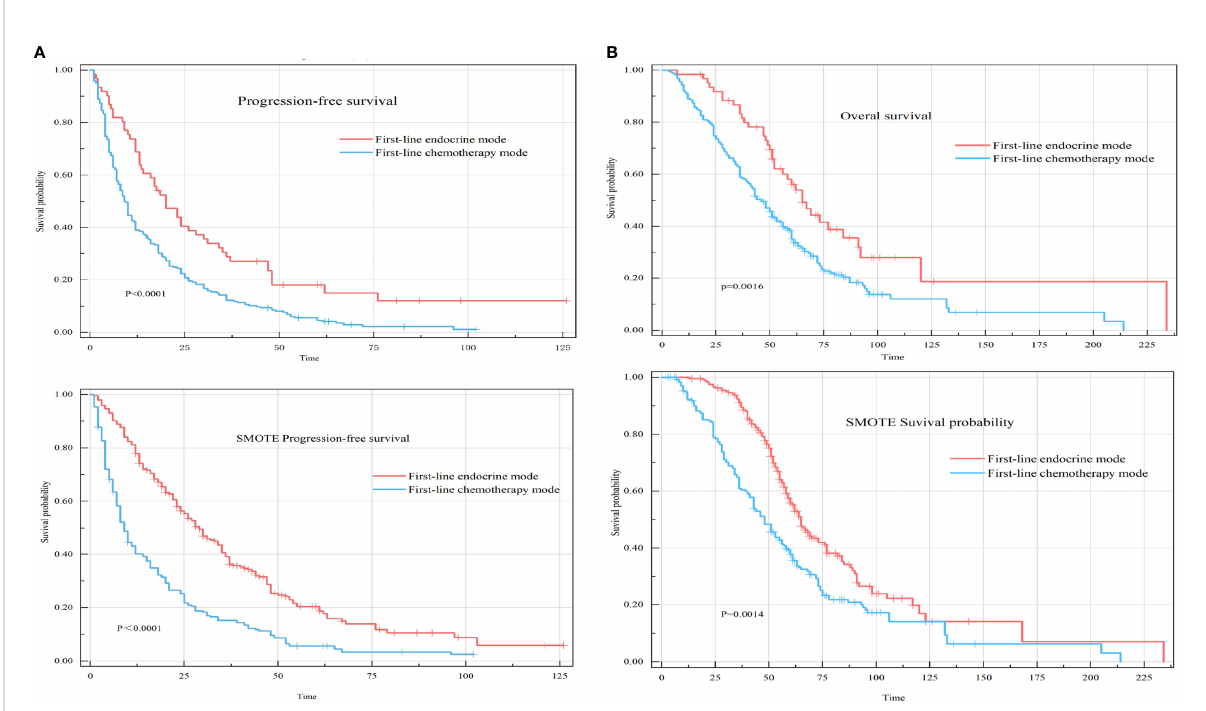
FIGURE 2 Progression-free survival (PFS) and overall survival (OS) of two different fi rst-line treatment modes for hormone receptor-positive HER-2- negative metastatic breast cancer (HR+HER-2-MBC) patients. (A) Kaplan – Meier curve of PFS in fi rst-line treatment modes. (B) Kaplan – Meier curve of OS in fi rst-line treatment